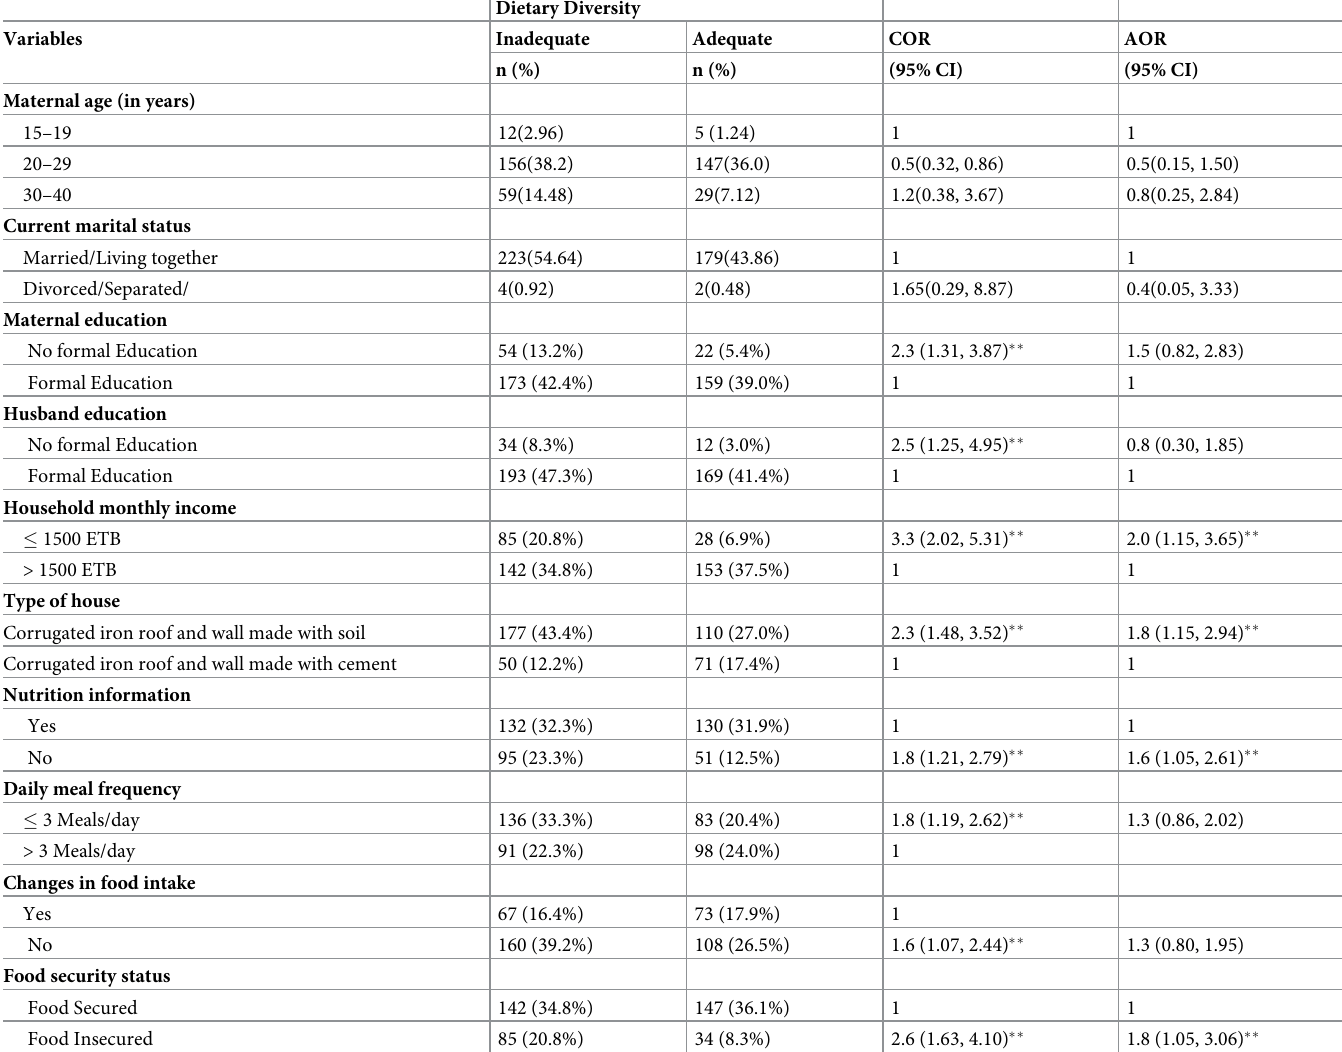
Table 3. Association of variables with dietary diversity of lactating mothers (n = 408) visiting governmental health facilities of Dessie town, Ethiopia, March-April,